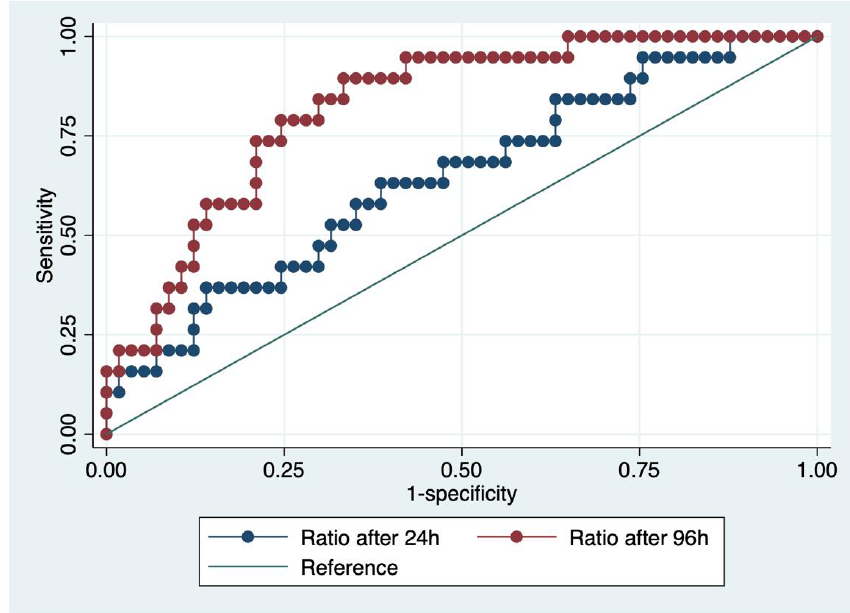
Figure 3. Receiver-operating-characteristics (ROC) curves for dsDNA/DNase ratio after 24 and 96 h. Table 3. Baseline characteristics, CPR-specific data, intensive care measures, and outcome data ac- cording to dsDNA/DNase ratio below and above the empirical cut-off value.